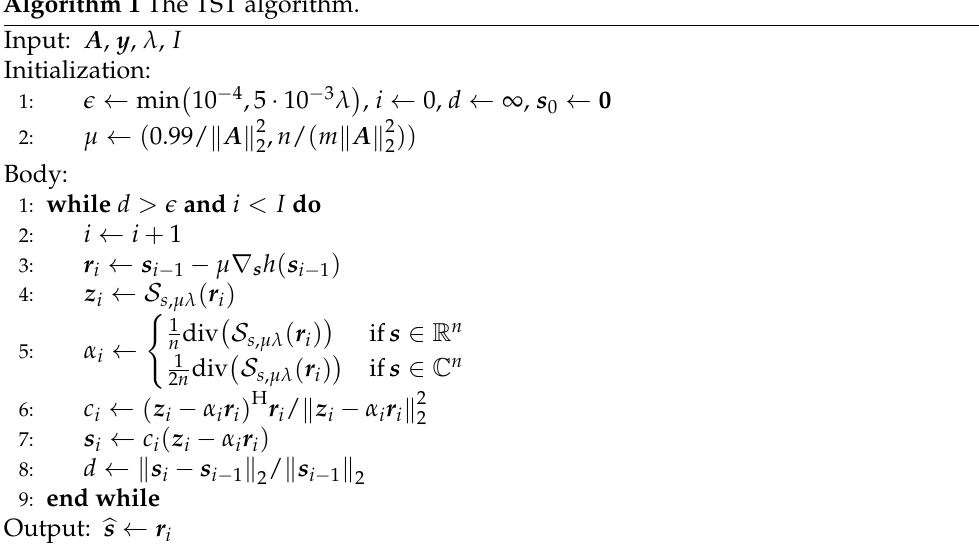
Algorithm 1 The TST